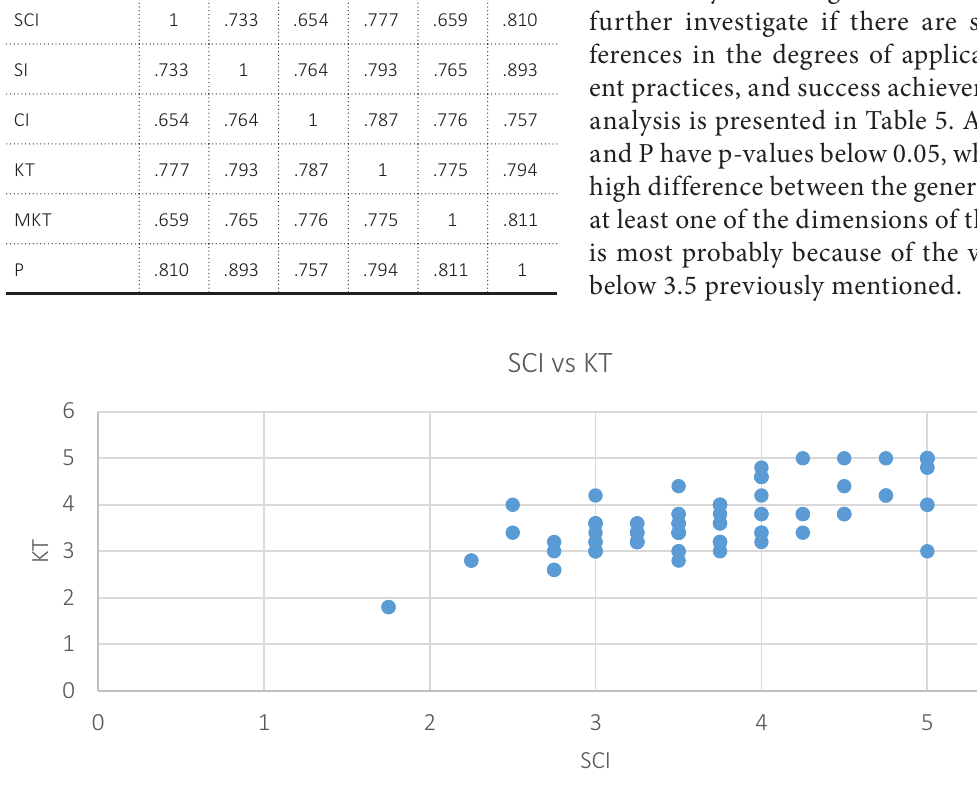
Figure 3. Relationship between SCI and